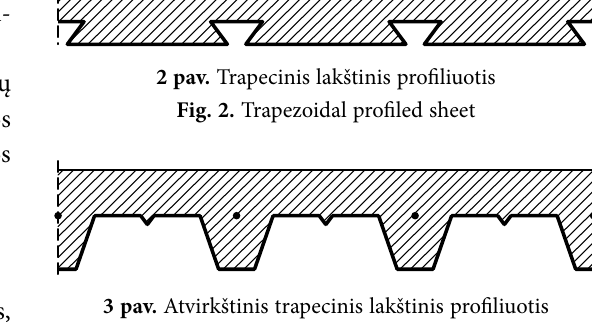
Fig. 3. Re-entrant profiled sheet